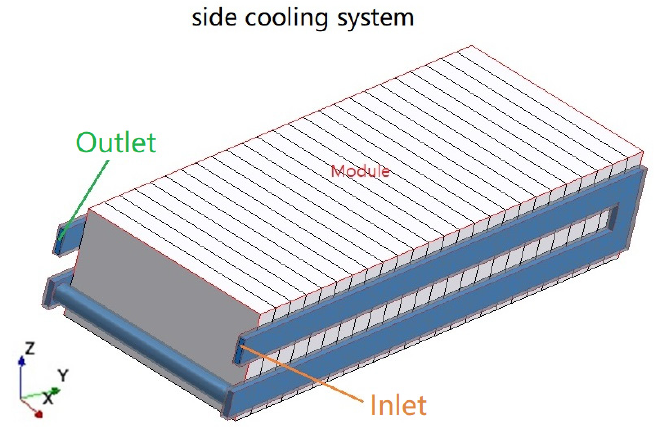
Figure 5. Perspective view of the coolant flow path created in the battery module for the side cooling system.